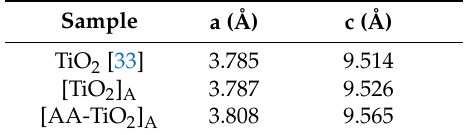
Figure 3. X-ray diffraction (XRD) patterns of ( a ) [TiO 2 ] A and [AA-TiO 2 ] A containing 2.5 wt % of AA; ( b ) Magnification of the 004 peak in the range in the range 20.5 – 23.0 deg. Table 1. Parameter cell values for TiO 2 [33], [TiO 2 ] A and [AA-TiO 2 ] A . Sample